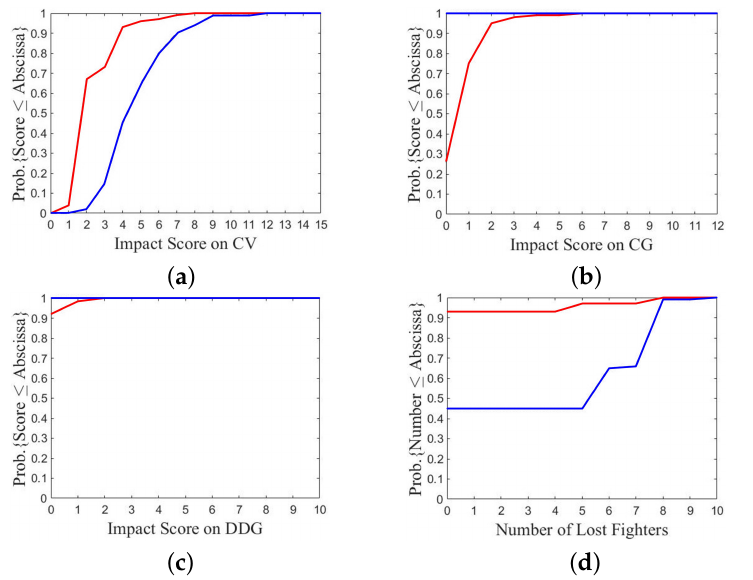
Figure 4. (A2/B3) Cumulative distribution of impact score on ( a ) CV ( b ) CG, ( c ) DDG, ( d ) fighters; over 100 games with one P 2 SO run, ———: fleet A, ———: fleet